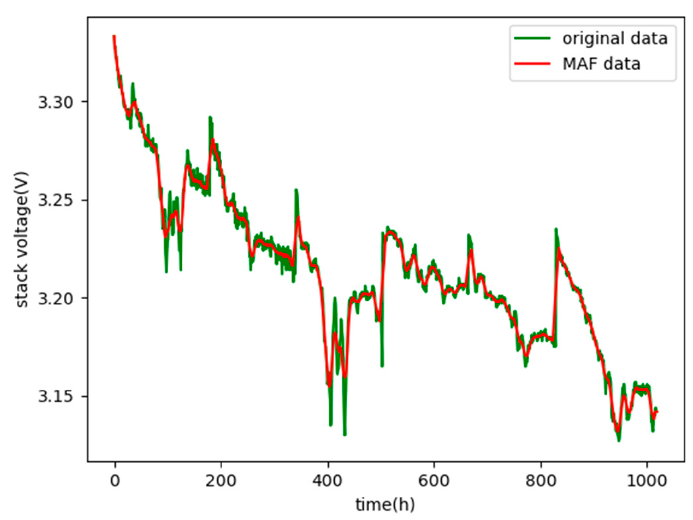
Figure 2. Comparison between the original stack voltage and the stack voltage after MAF.